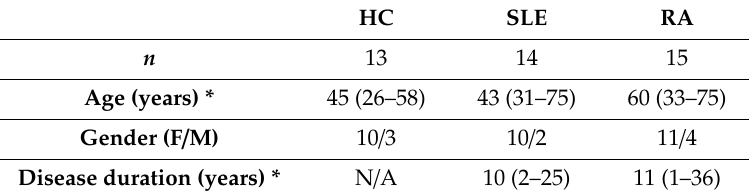
Table 1. Demographic and clinical characteristics of study